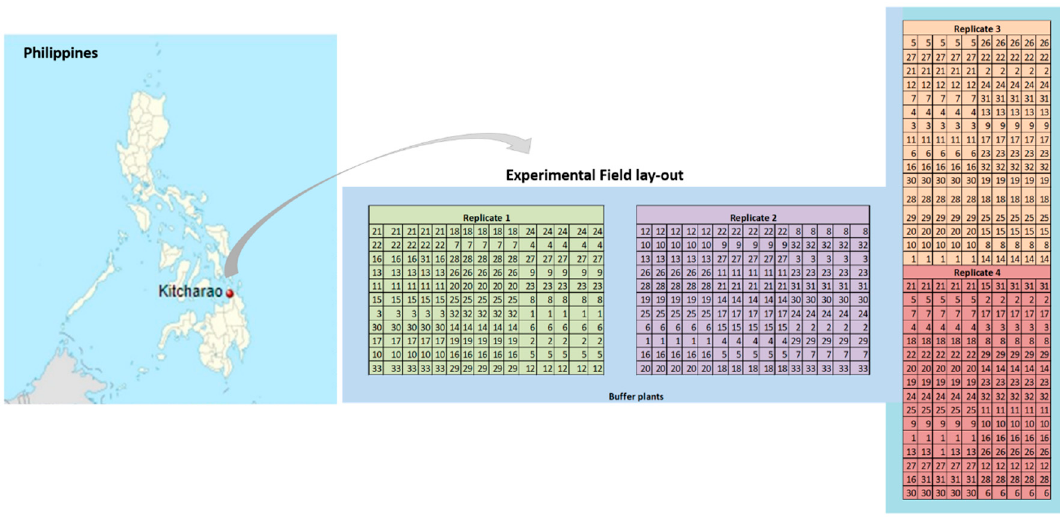
Figure 1. Field trial site of 33 native species for domestication and their experimental layout in Kitcharao, Agusan del Norte, Philippines.